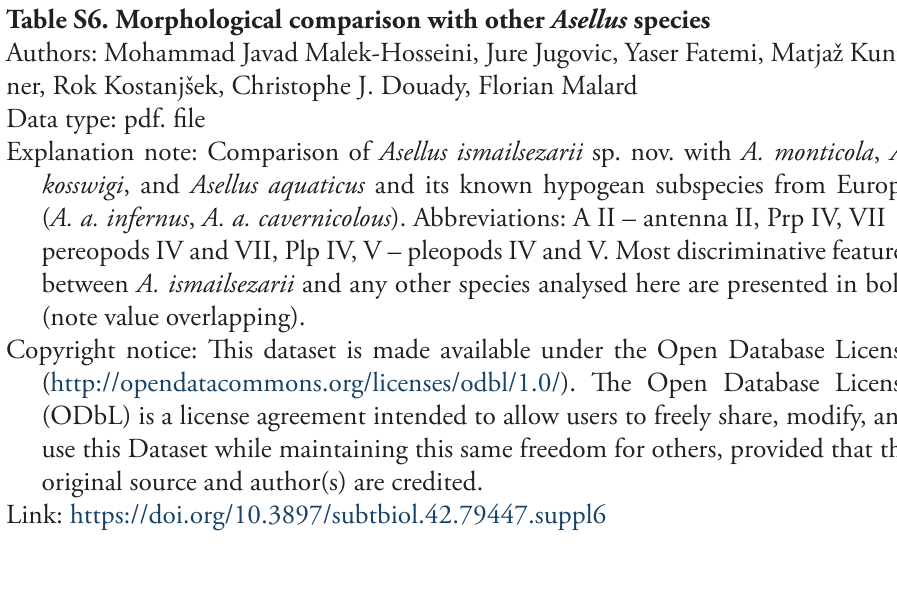
Table S6. Morphological comparison with other Asellus